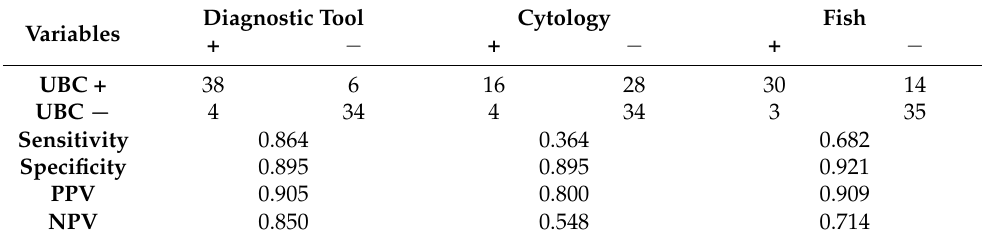
Table 3. The diagnostic performance of different techniques in cohort